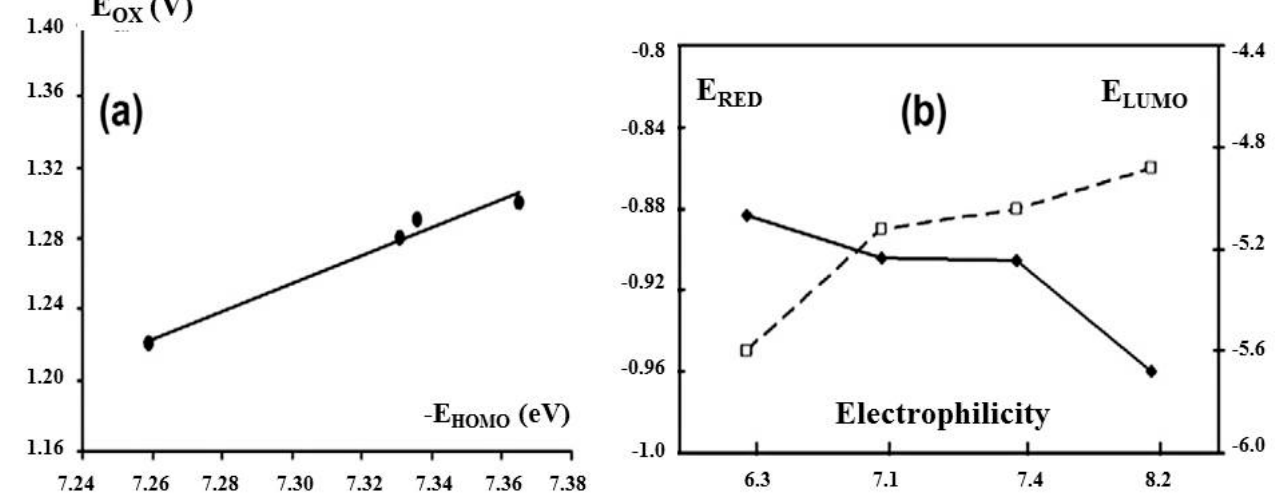
Figure 19. ( a ) Linear correlation between the oxidation potential and the HOMO energy. ( b ) Influence of the ligand electrophilicity on the reduction potential (line) and in the LUMO energy